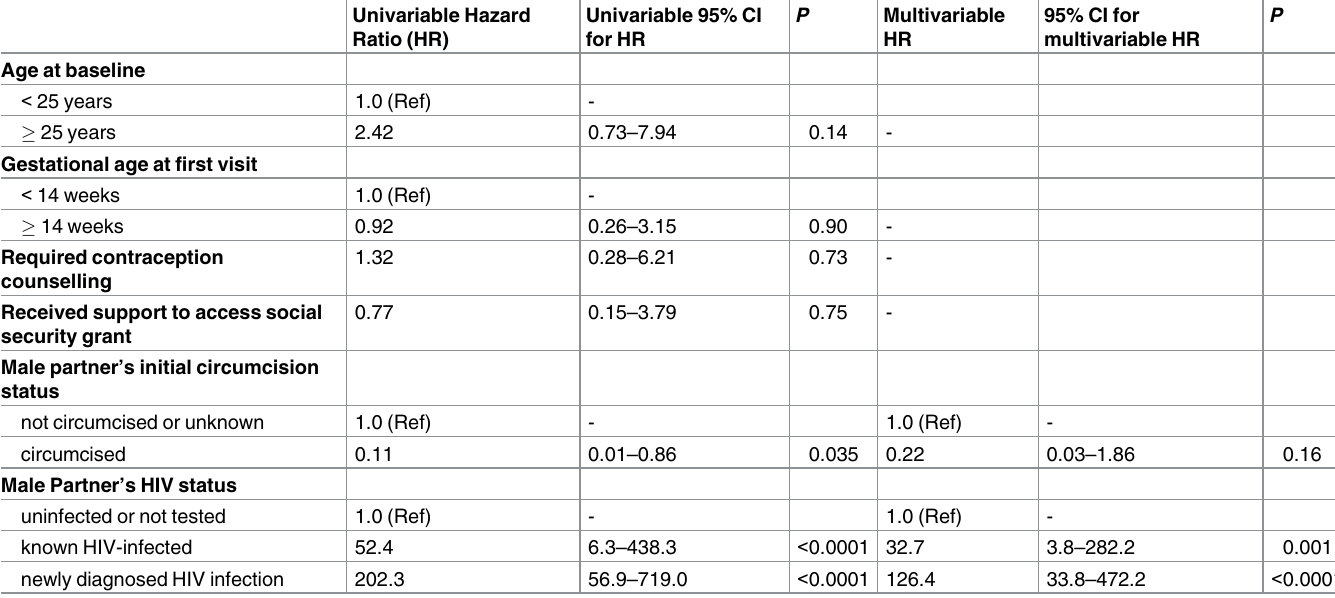
Table 2. Univariable and multivariable Cox regression of factors associated with incident maternal HIV infection (n =